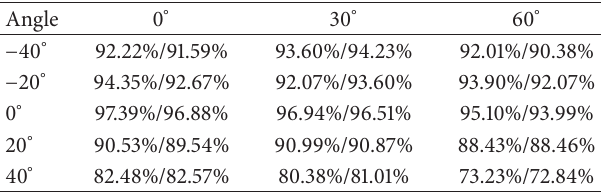
Table 2: Illumination estimation performance under certain poses (1st row indicates pan angle; 1st column indicates tilt angle).